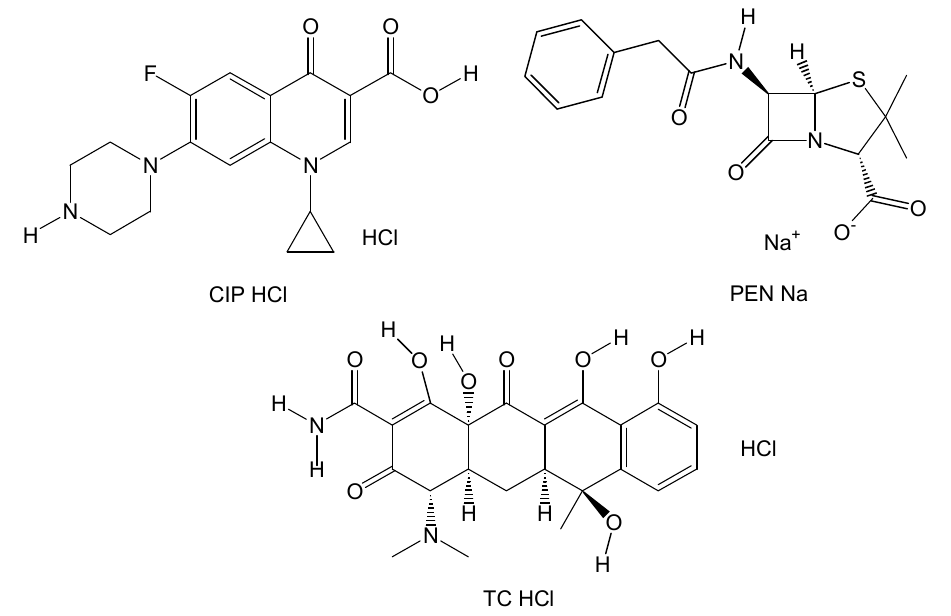
Scheme 1. Molecular structures of CIP·HCl , PEN·Na , and TC·HCl